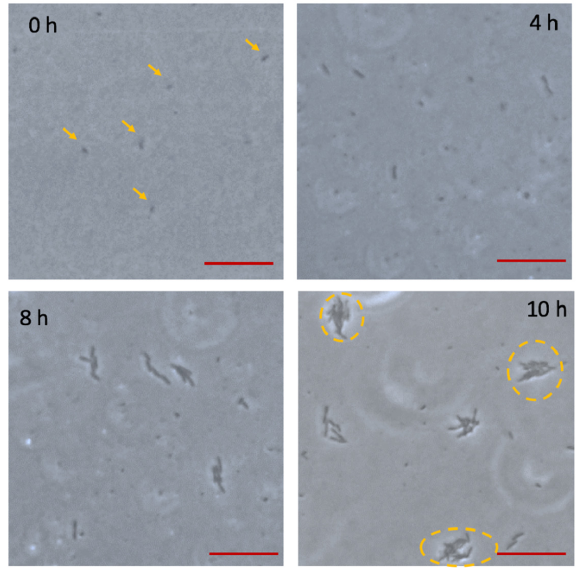
Figure 2. The photomicrograph of bacteria culture on chip in continuous flow at 0 h, 4 h, 8 h, 10 h. At 0 h, bacteria distribute in monolayer. At 4 h, bacteria adhere to the surface and grow. At 8 h, semitransparent substances surrounding the bacteria begin to form. At 10 h, bacteria grow into multilayers, and biofilms can be observed obviously. The scale bar is 5 μ m.